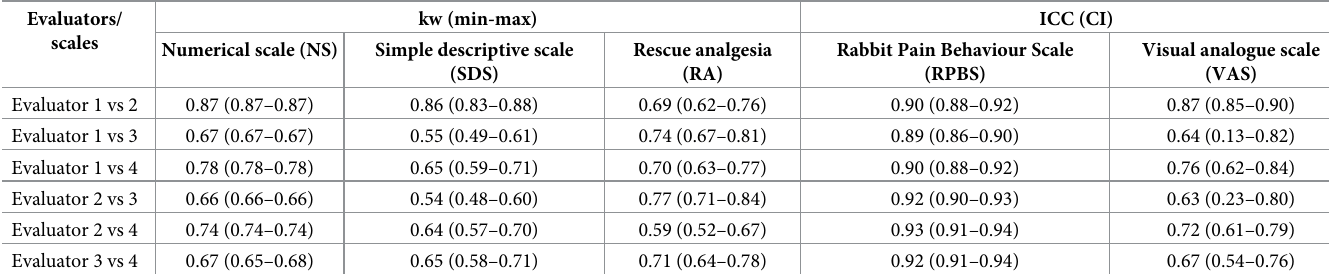
Table 7. Inter-observer reliability of RPBS, unidimensional scales, and rescue analgesia indication between observers. Evaluators/